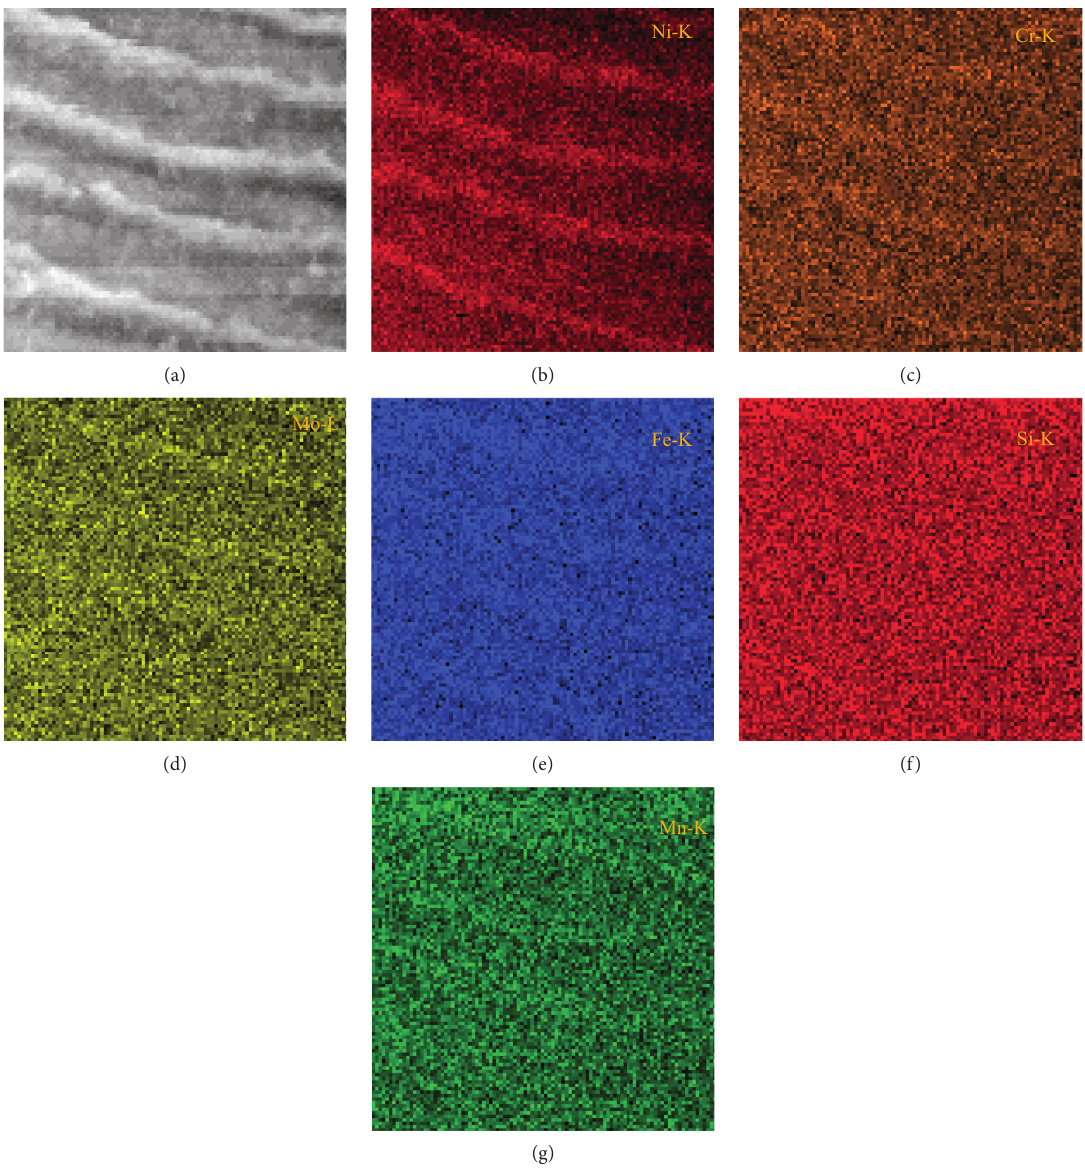
Figure 3: Morphology and element mapping results of Hastelloy N along the < 110 > belt axis after ion irradiation